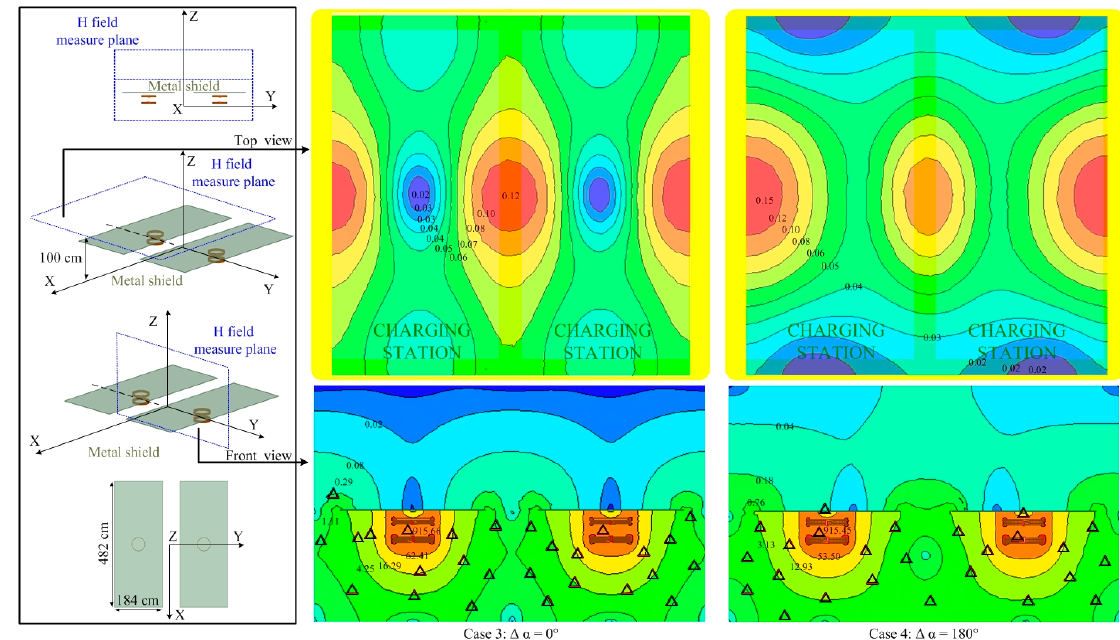
Figure 6. Magnetic field intensity (A/m) of two parallel WPT systems with a metal shield.